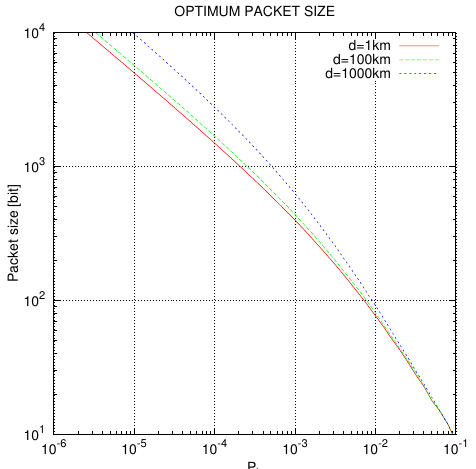
Figure 4. Optimum packet size for QPSK with symbol rate f s = 80 k , convolutional coding with coding rate r = 3/4, k = 9, and BER P b = 10 − 4